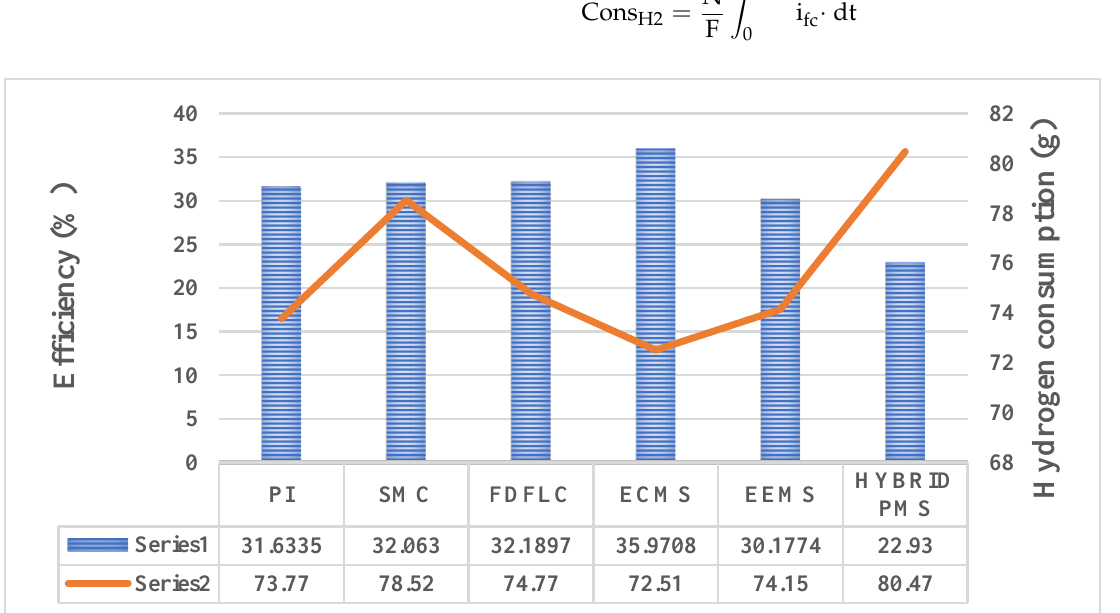
Figure 12. System efficiency and hydrogen consumption for each scheme (HWFET — Drive Cycle).